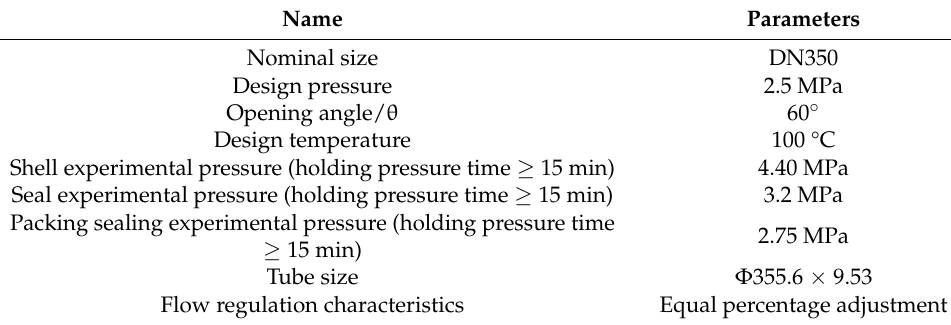
Figure 1. 3D model of DN350 electric ball valve: 1. Left valve body; 2. Sealing ring; 3. Stand; 4. Upper valve shaft; 5.V-channel ball body; 6. Right valve body; 7. Valve seat; 8. Lower valve shaft. Table 1. Main performance parameters of DN350 electric ball valve.